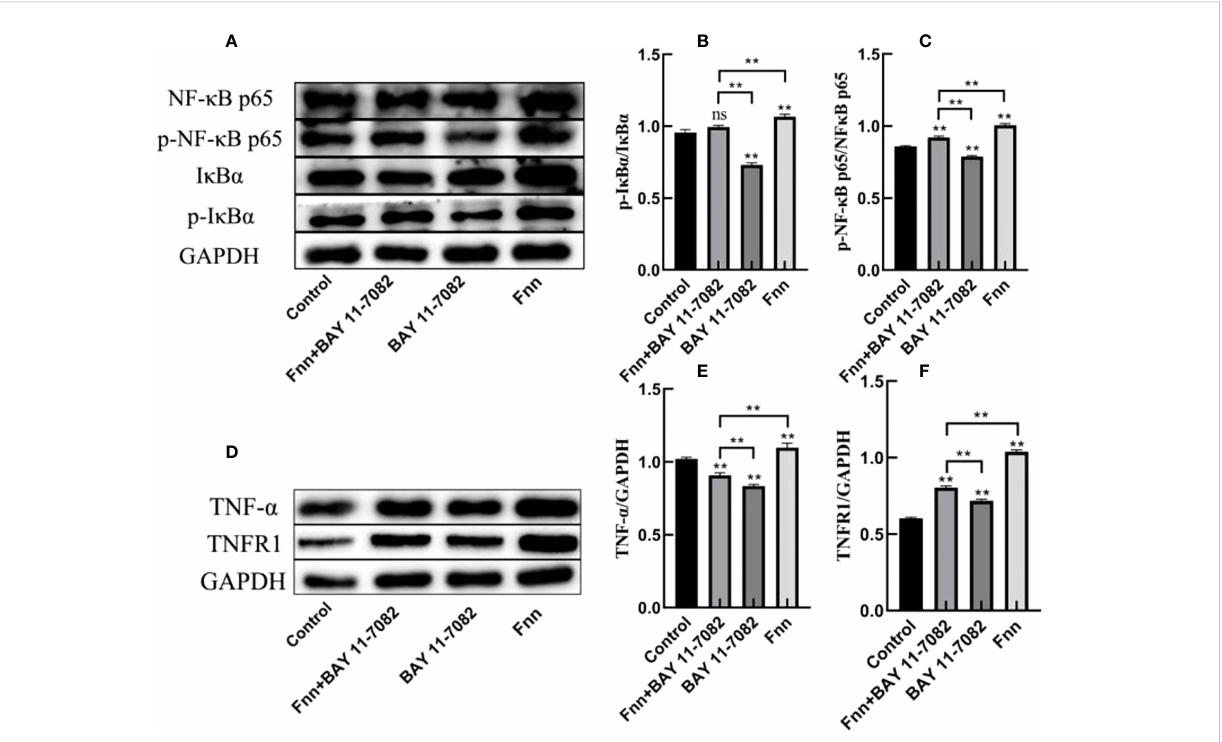
FIGURE 5 Activation of the nuclear factor- k B (NF- k B) signaling pathway in intertoe explants by F. necrophorum infection. Skin explants were treated with F. necrophorum a concentration of 1 × 10 8 /mL and/or 50 mM BAY 11-7082 for 24 h. (A) Western blotting results of p-NF- k B p65, NF- k B p65, p-I k B a , and I k B a . (B) Phosphorylation levels of I k B a . (C) Phosphorylation levels of NF- k B p65. (D) Western blotting results of TNF- a and TNFR1. (E) Signi fi cant relationship of TNF- a expression. (F) Signi fi cant relationship of TNFR1 expression. The data presented are the mean ± SD. *statistical signi fi cance (P < 0.05).